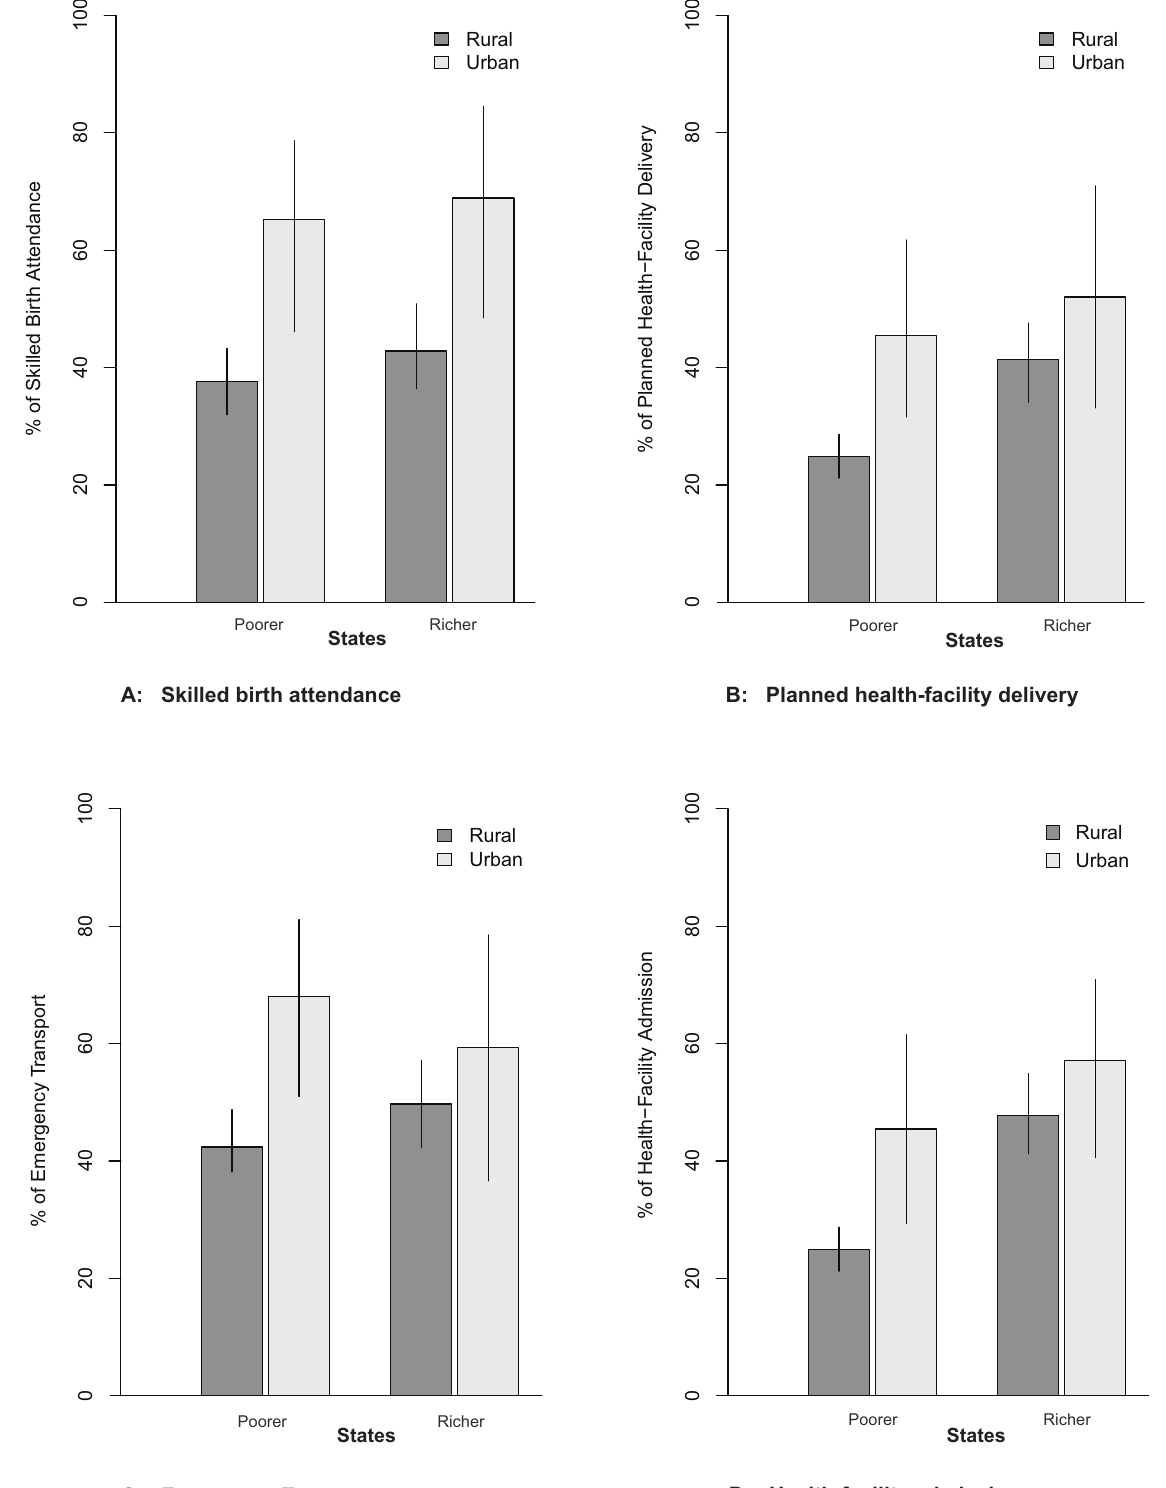
Figure 4. Uptake of routine and emergency healthcare in poorer and richer states, by rural urban areas. Datasource: Indian SRS 2001–3 data. Graphs A and B for subgroup of women who experienced spontaneous labour onset or arranged a medical abortion (n=732) (i.e. omitting those for whom a complication arose prior to the need for of routine care). A :Skilled birth attendance comparison of rural and urban area of poorer states (p=0.0022) and richer states (p=0.0435) and B : Planned health-facility delivery comparison of rural and urban of poorer states (p=0.0435) and richer states (p=0.3061). Graphs C and D for all maternal deaths in the sample (n=1096). C : Emergency transport comparison of rural and urban